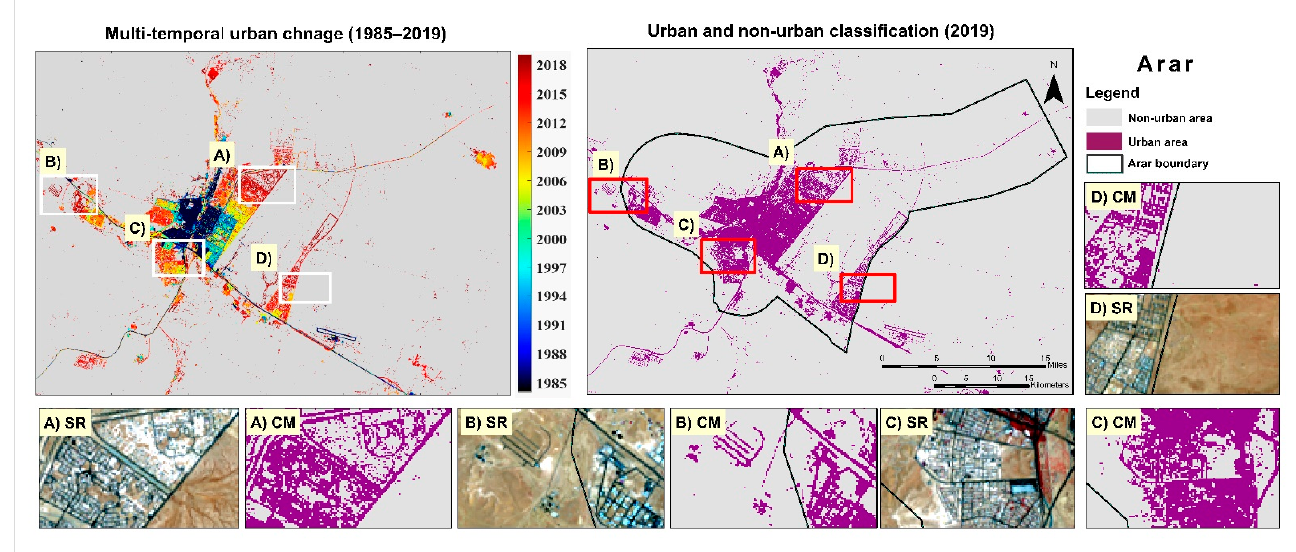
Figure 12. Multi-temporal urban change map (1985–2019) and urban and non-urban classifications in 2019 in Arar. Both include surface reflectance (SR) and classification map (CM) samples.